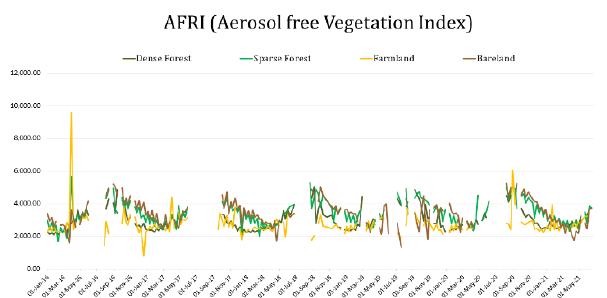
Fig. 5: Mean AFRI for 30 random points taken in each land cover class of Mizoram area from year